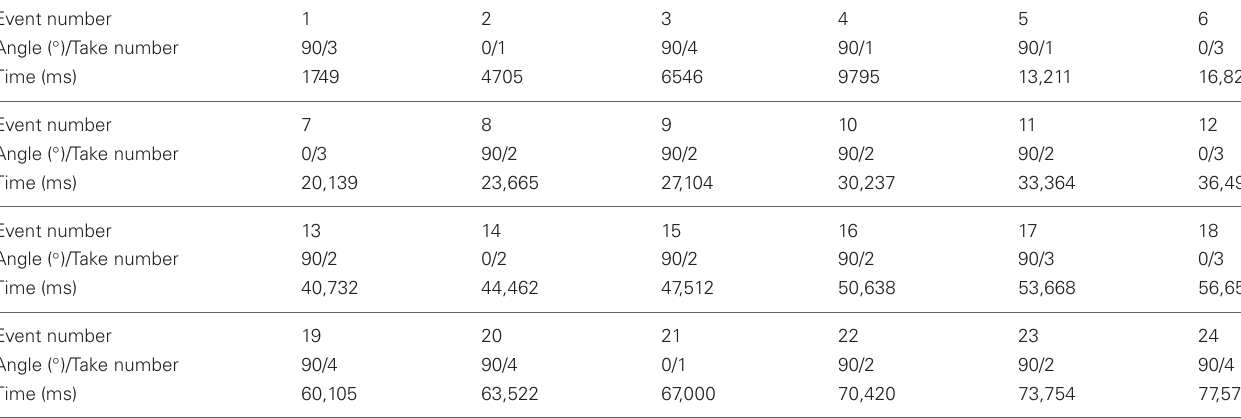
Table A1 | Event key for example audio